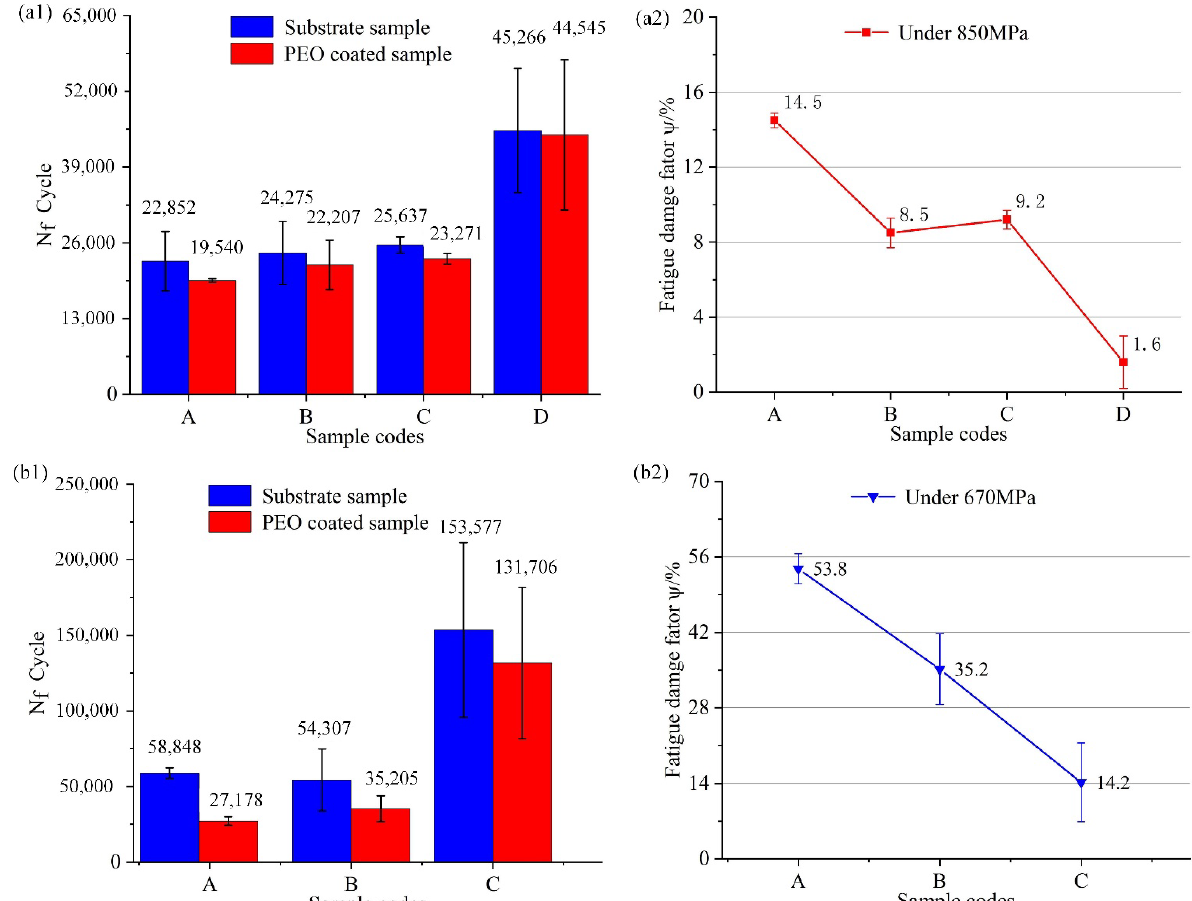
Figure 9. Fatigue strength of the substrate and PEO-coated samples: Substrate roughness of (A) 3.2, (B) 1.6, (C) 0.8, (D) 0.2 µm. ( a1 ) Fatigue life of substrate and PEO-coated samples under 850 MPa.